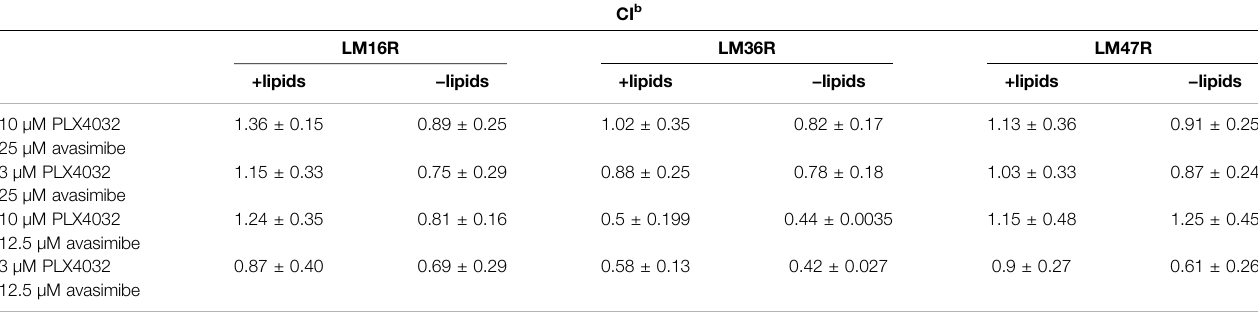
TABLE 2 | Analysis of the drug interaction between PLX4032 and avasimibe in LM16R, LM36R and LM47R cells a